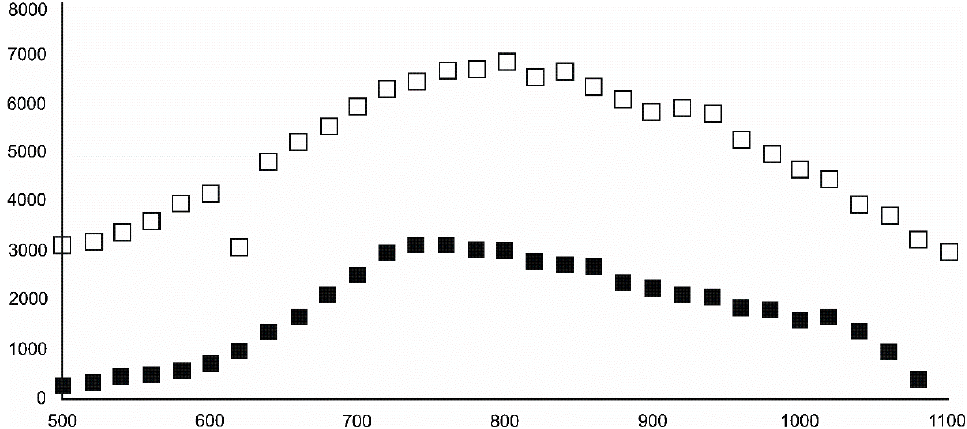
Figure 11. Progressive metamorphism imitation (heating) data for wüstite. Relation of temperature (bottom axis, °C) to number of counts derived from the intensity of the main reflection (hkl = 200; left axis, arbitrary units). Symbols as in Figure 10.